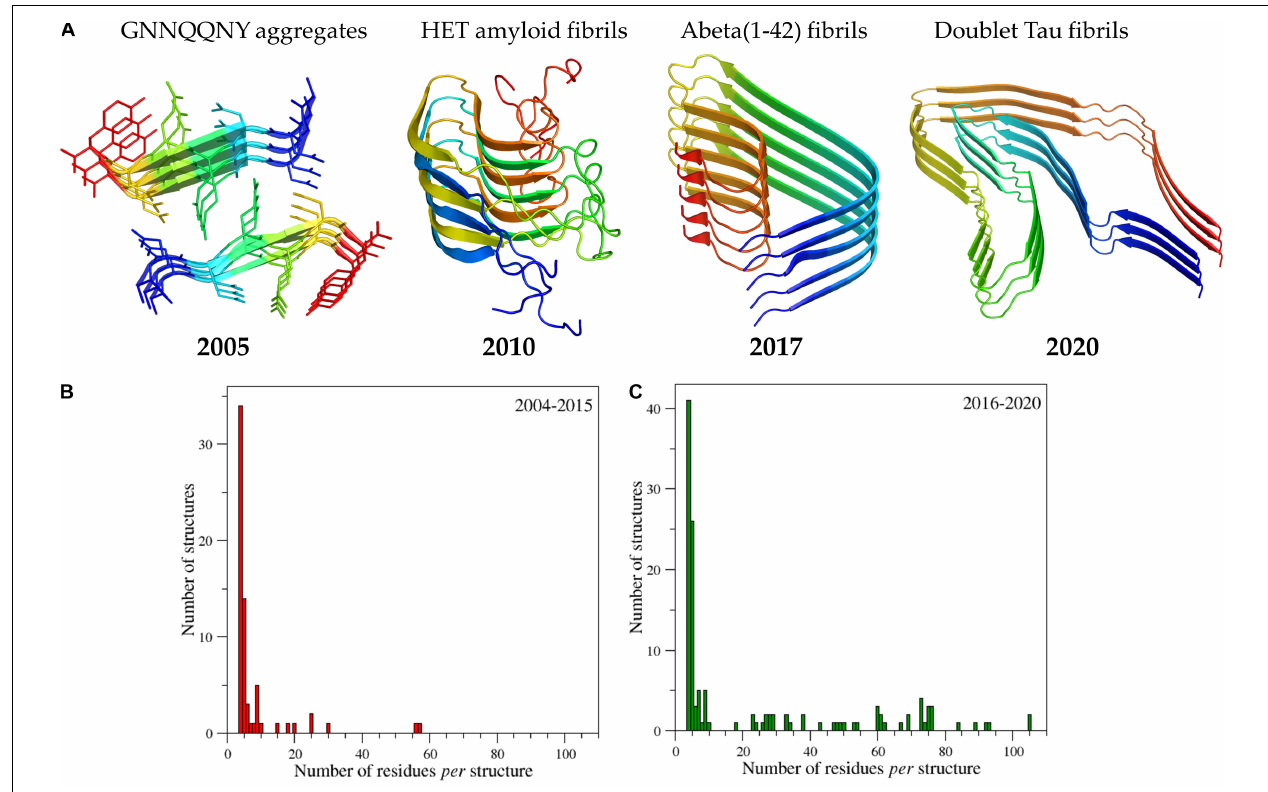
FIGURE 3 | Progressive increase of structural complexity of the cross- β systems whose structure has been determined at atomic levels starting from the GNNQQNY peptide to the human brain-derived Tau filaments (A) . The PDB code of the structures reported from the left to the right of panel (A) are 1yjp, 2kj3, 5oqv, and 6vh7. Ribbons are represented with a color code (blue to red) from the N- to the C-terminus. The panels (B) and (C) report the number of amyloid structures as function of the size deposited in the time interval 2004-2015 and 2016-2020, respectively. The initial search for amyloid-like structures was performed by interrogating the entire PDB (release of October 2020) using as a query the following criteria: Polymer Entity Type = “Protein”; Experimental Method = X-ray diffraction, electron microscopy, electron crystallography, solid-state NMR, fiber diffraction, neutron diffraction, solution scattering; Additional Structure Keywords = “amyloid”; Polymer Entity Sequence Length > 5. The PDB structures identified by the server were then manually checked and their main features were reported in the Supplementary Table 1